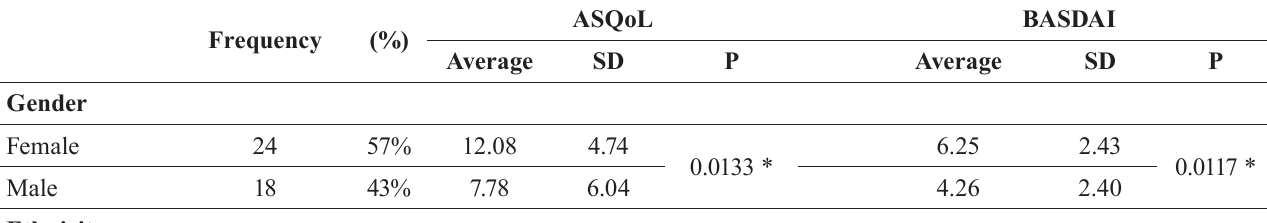
TABLE II – Frequency distribution and analysis of variance for the ASQoL and BASDAI indexes, according to demographic